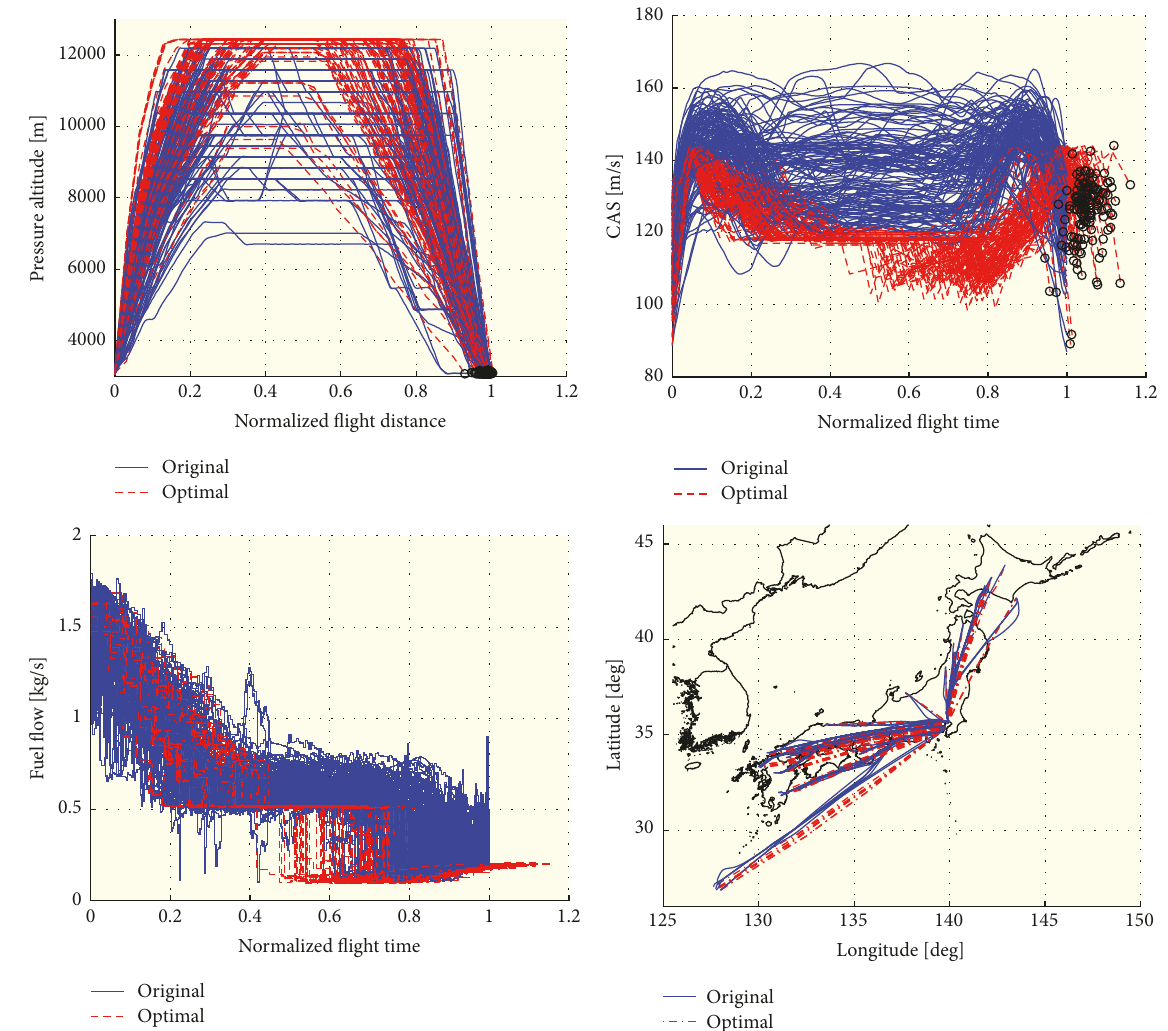
Figure 10: Pressure altitude, CAS, fuel flow, and flight path of the original and optimal departure flights from Haneda